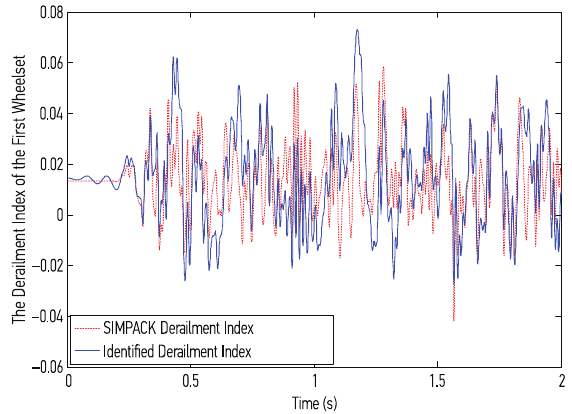
Fig. 10. Comparison of index coefficient for first